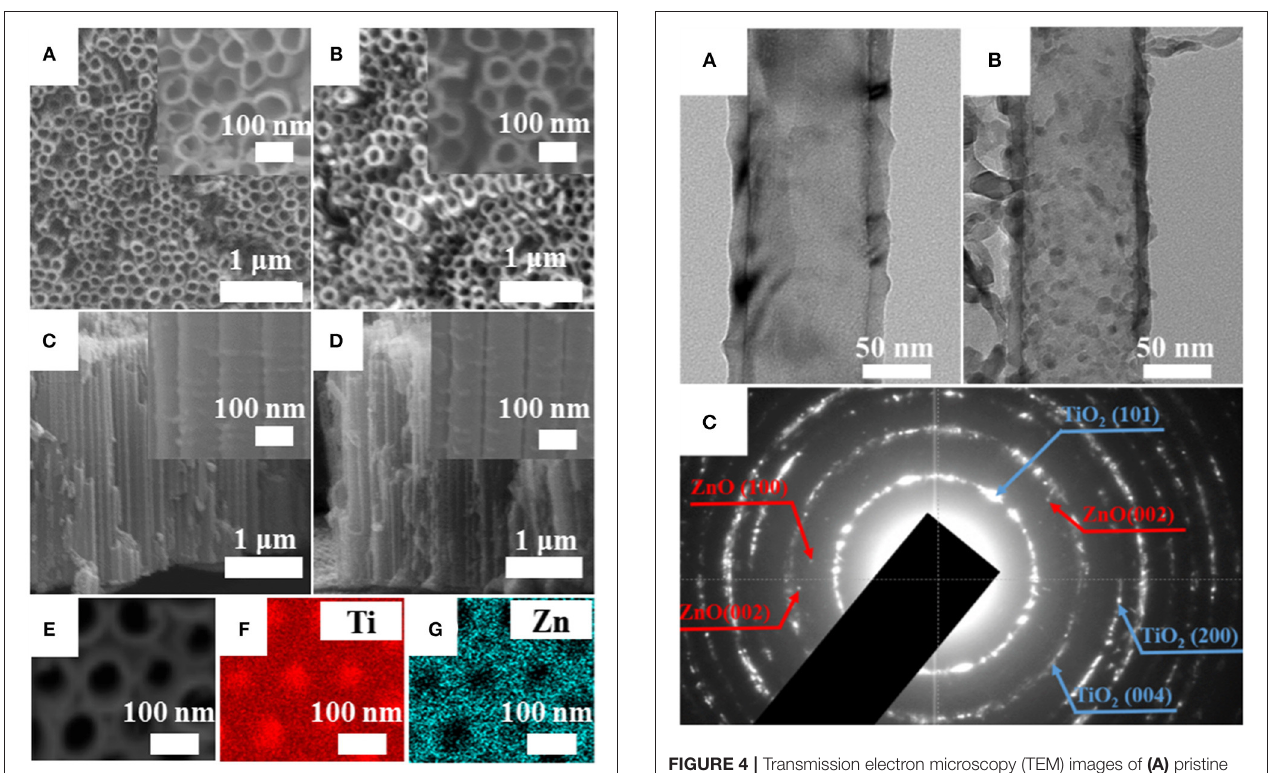
FIGURE 3 | Scanning electron microscopy (SEM) images of (A,B) surface and (C,D) cross-sectional view of (A,C) pristine TiO 2 and (B,D) TiO 2 @ZnO nanotubes. Energy-dispersive spectrometer (EDS) elemental images of TiO 2 @ZnO with (E) SEM images, (F) Ti, and (G) Zn.